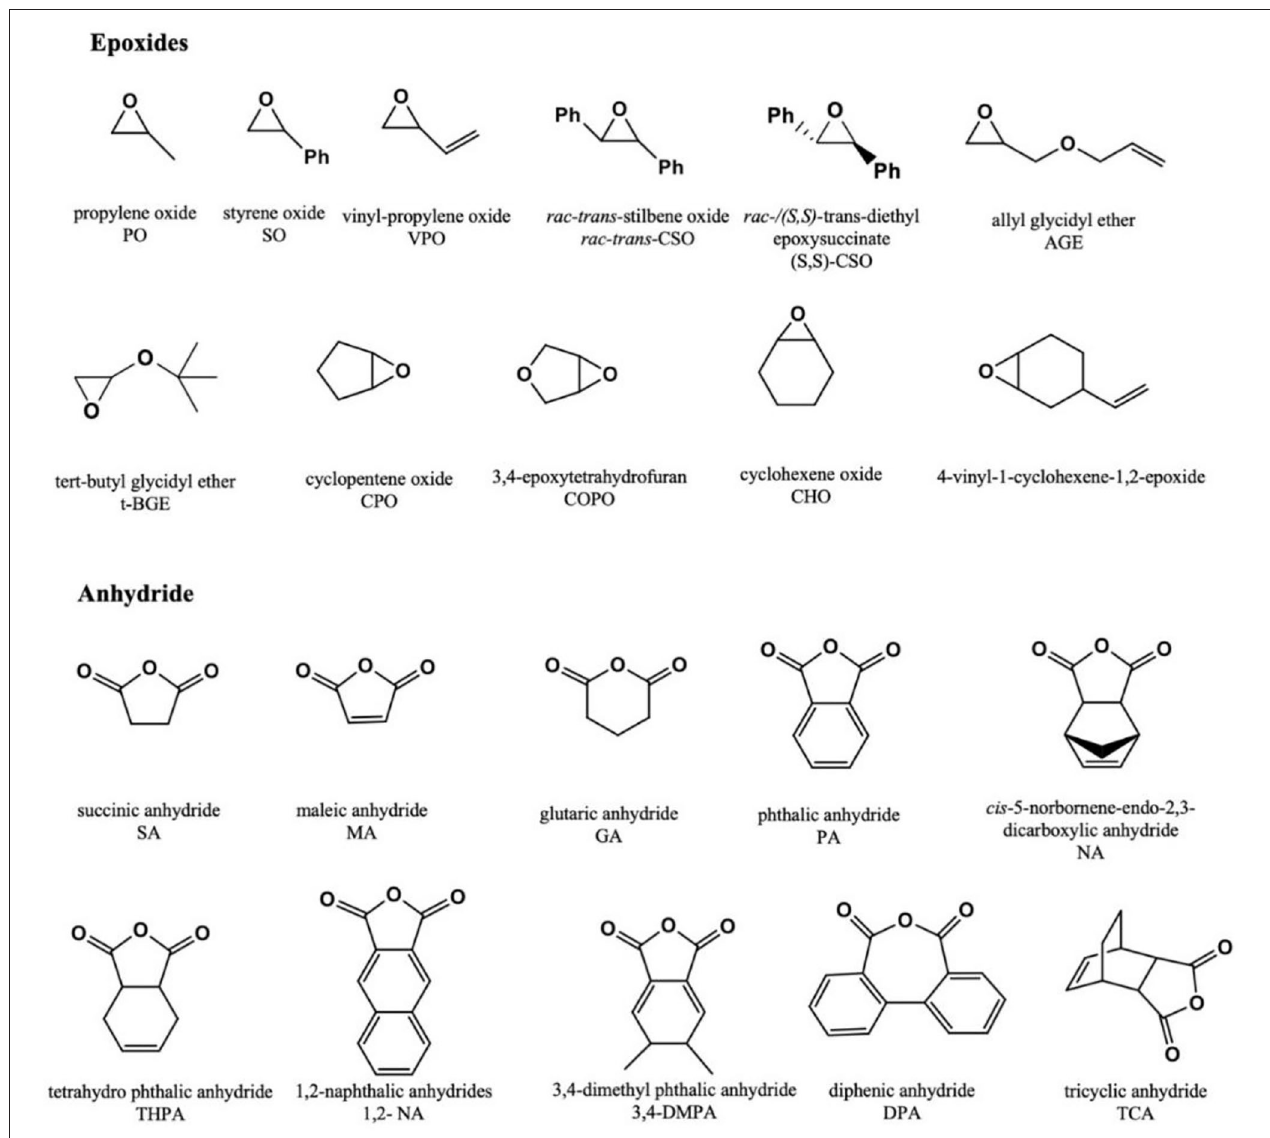
FIGURE 1 | The structures of epoxides and anhydrides discussed in this